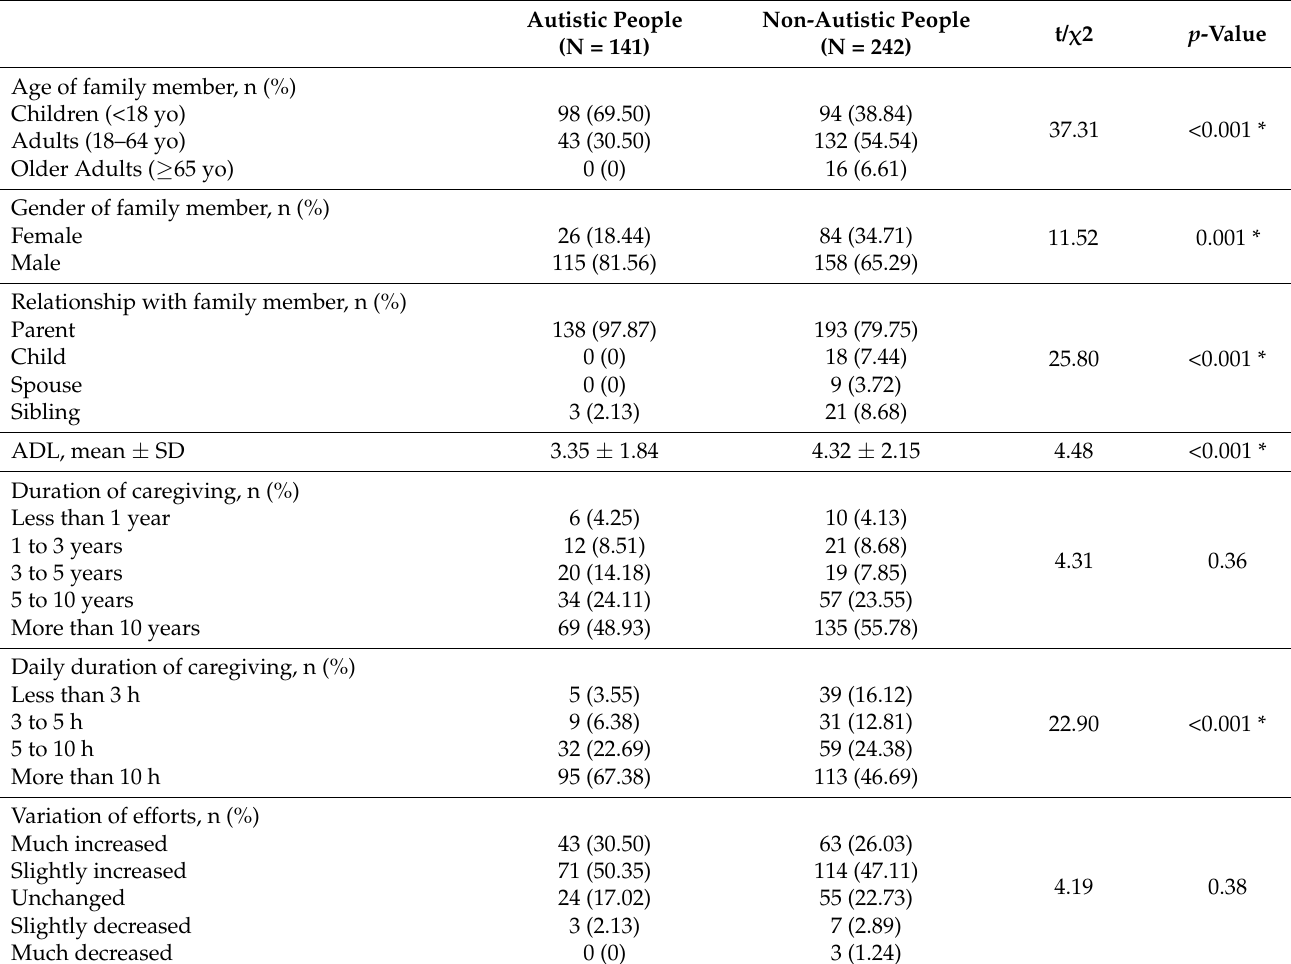
Table 2. Characteristics of the autistic and non-autistic family members of the web-survey